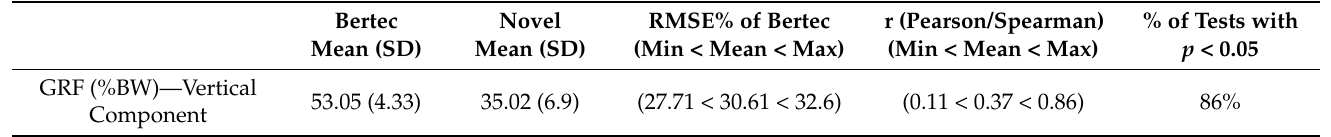
Table 3. Results of the comparison between the vertical component of GRF recorded through the force plates and the plantar pressure system: RMSE% and Pearson/Spearman’s correlation